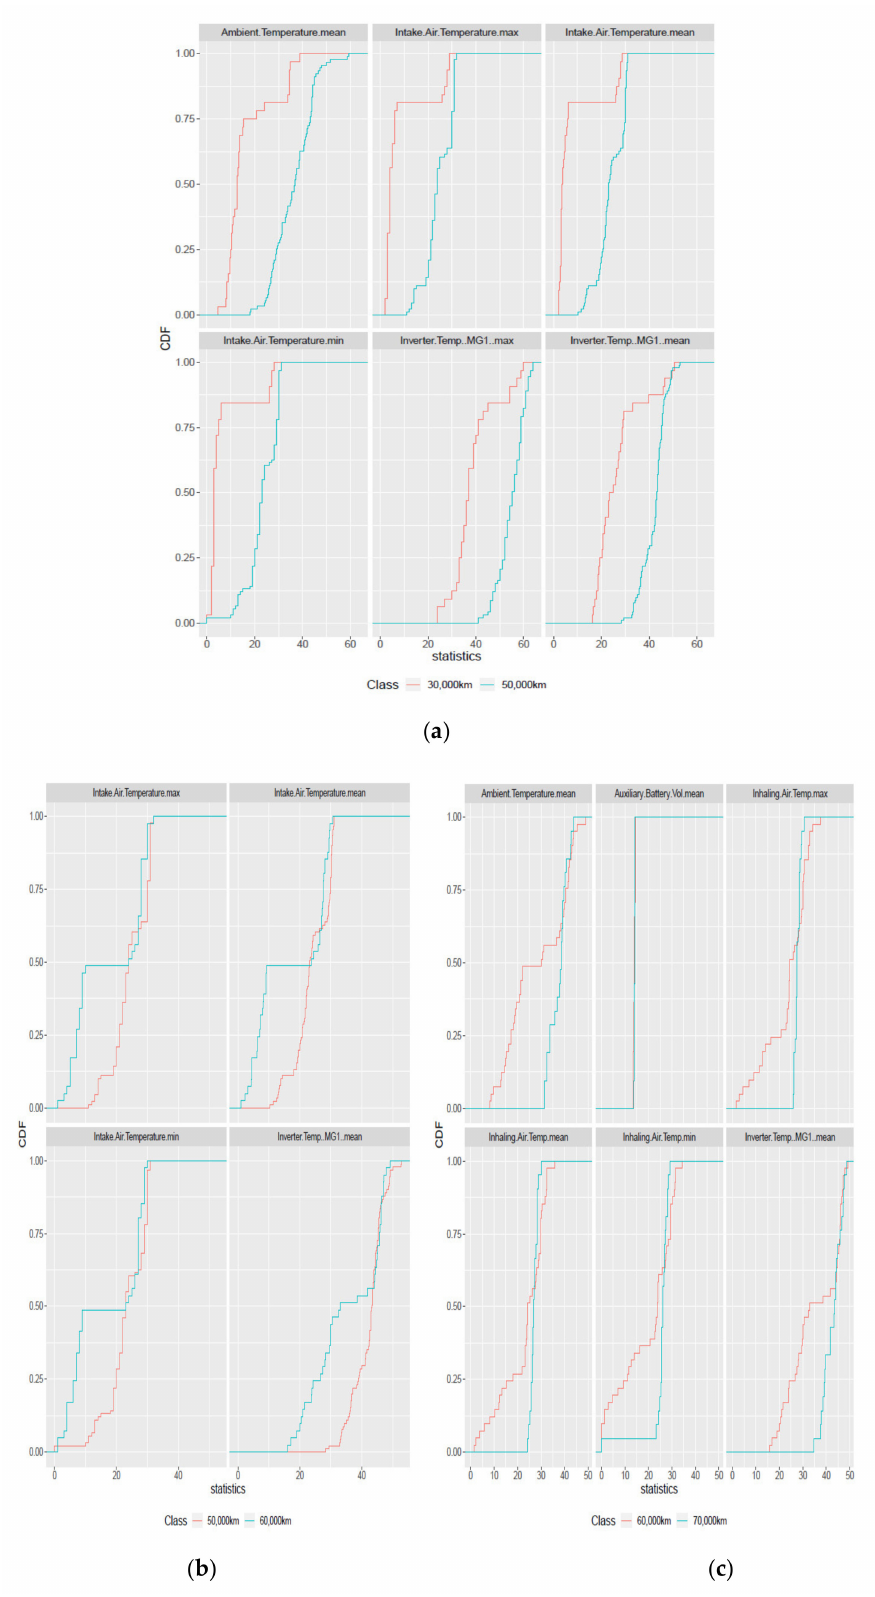
Figure 6. CDF plot of major features of vehicle parts showing many di ff erences: ( a ) from 30,000 to 50,000 km; ( b ) from 50,000 to 60,000 km; ( c ) from 60,000 to 70,000